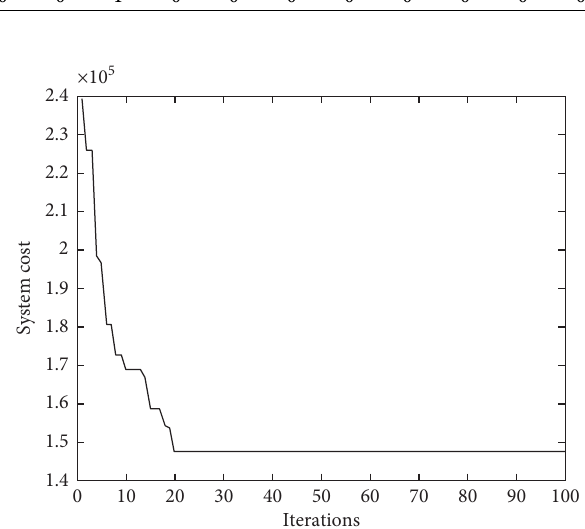
Figure 3: Evolutionary process diagram of algorithm. Table 4: Lane deployment schemes for different MPR.